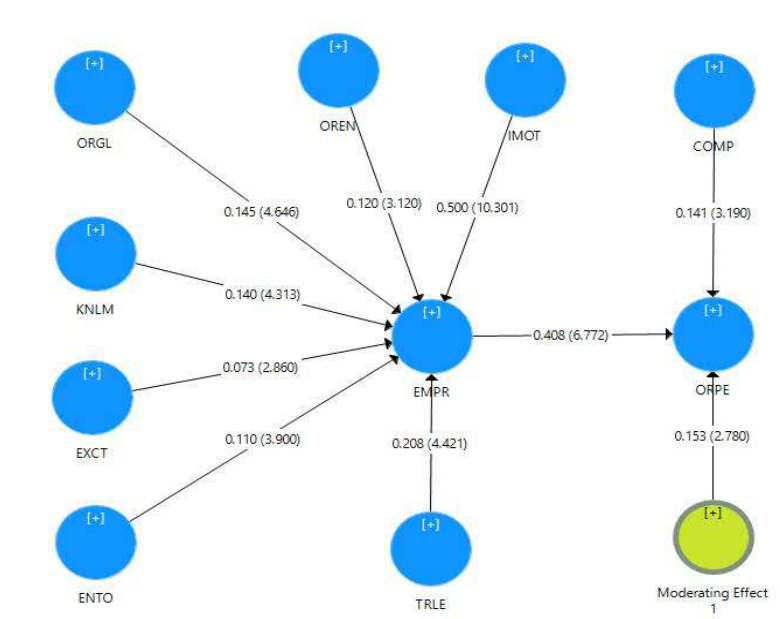
Fig. 3. Path Coefficients and